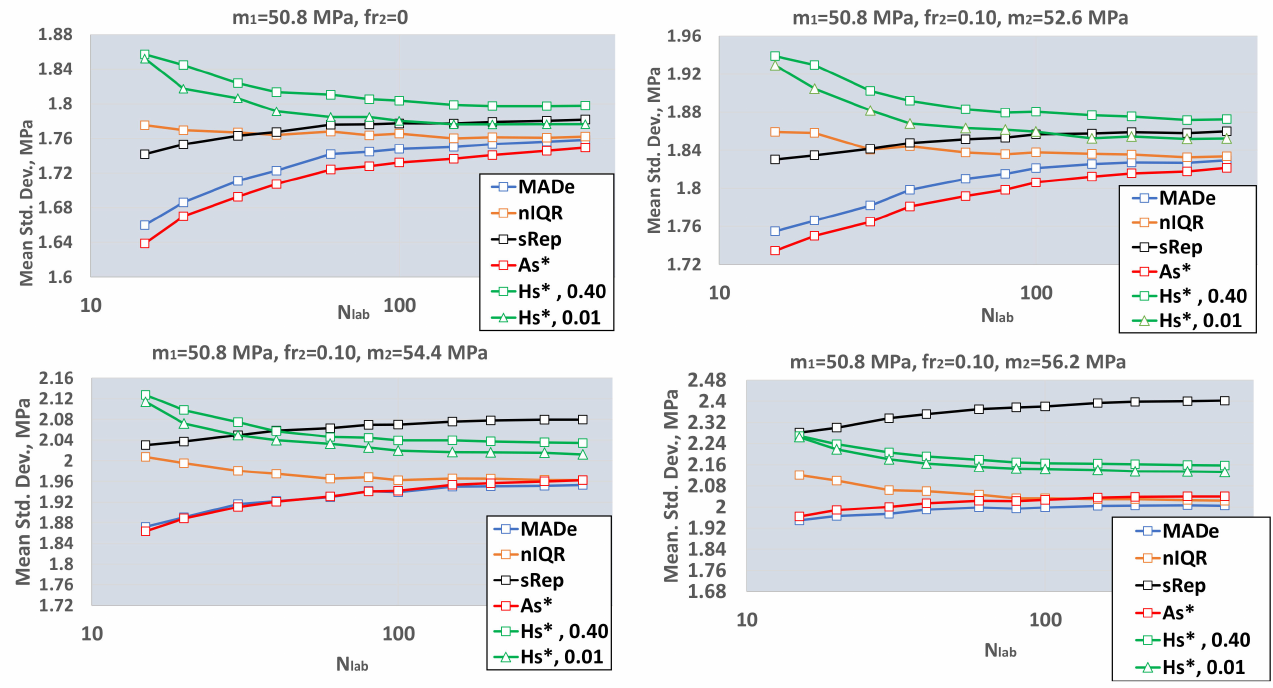
Figure 5. Average values of the population standard deviations. MADe : scaled median absolute deviation; nIQR : normalized interquartile range; sRep : reproducibility standard deviation without outliers; As* : standard deviation—Algorithm A; Hs* , 0.40: standard deviation using Q method and s r = 0.40; Hs* , 0.01: standard deviation using the Q method and s r = 0.01.